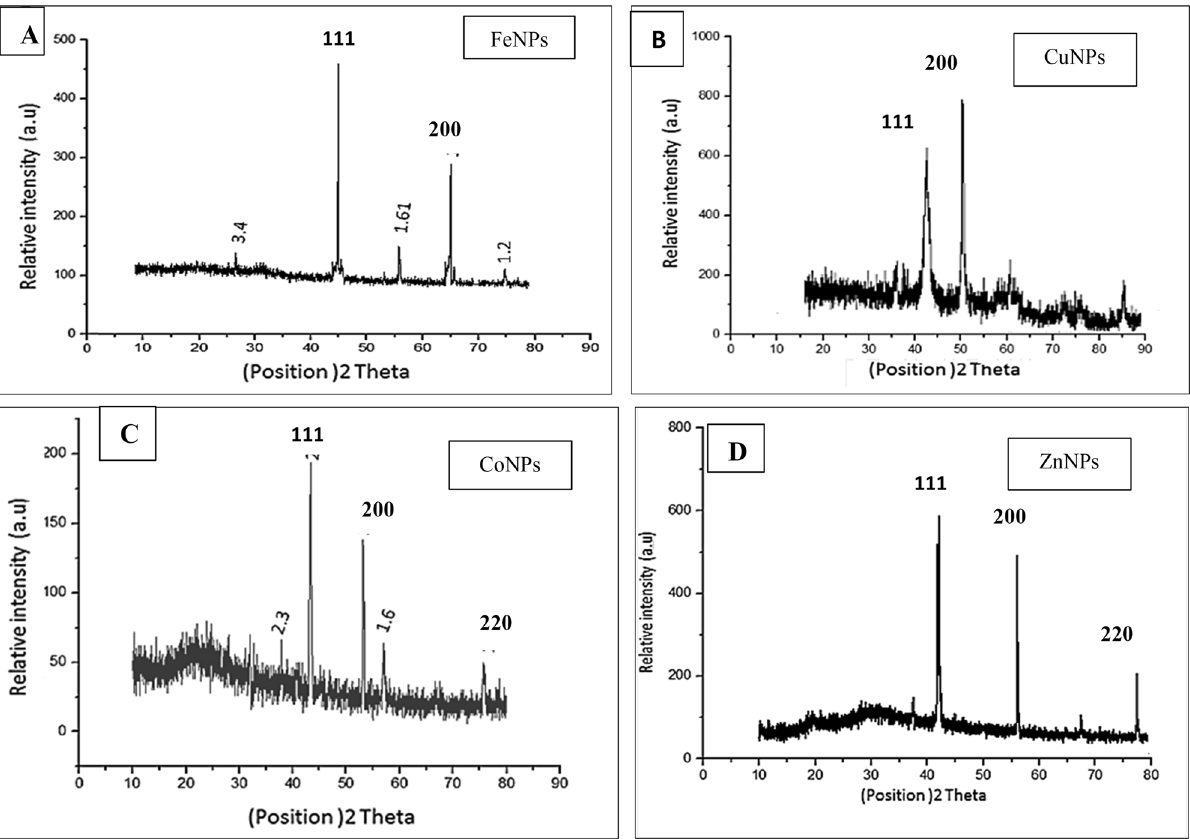
Figure 7. X-ray powder diffraction pattern of FeNPs ( A ), CuNPs ( B ), CoNPs ( C ) and ZnNPs ( D